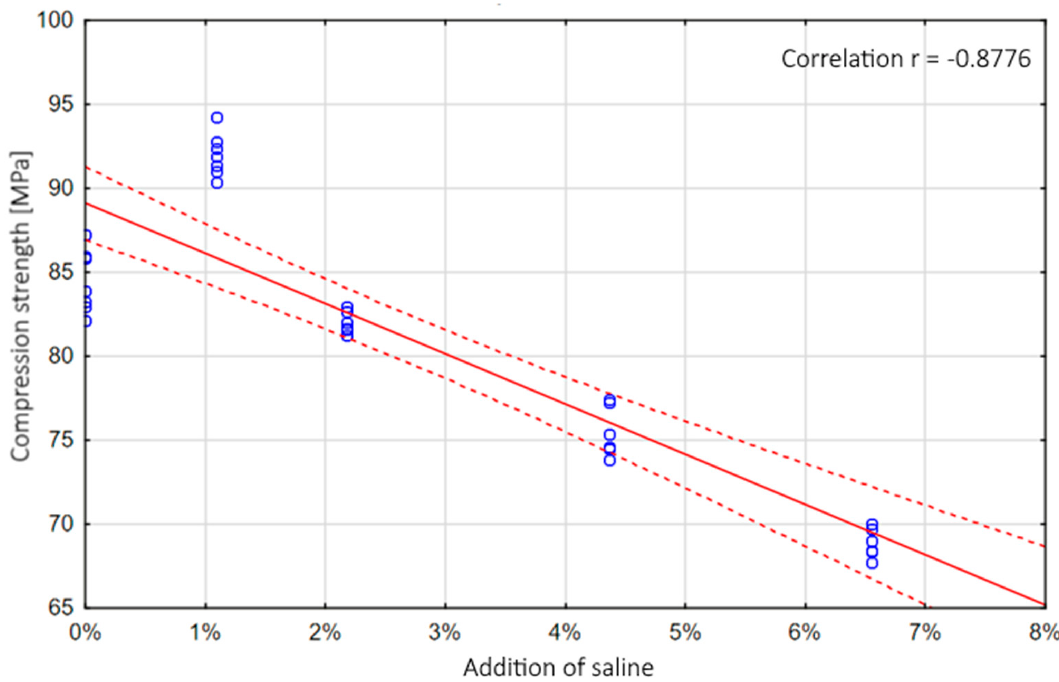
Figure 7. Comparison of the correlation between the admixture level and the compression strength of samples contaminated with saline up to approx. 8% by weight. Table 1. Parameters of selected polynomial models— α 1 x 4 + α 2 x 3 + α 3 x 2 + a 4 x + ε —obtained from 0–8% data.